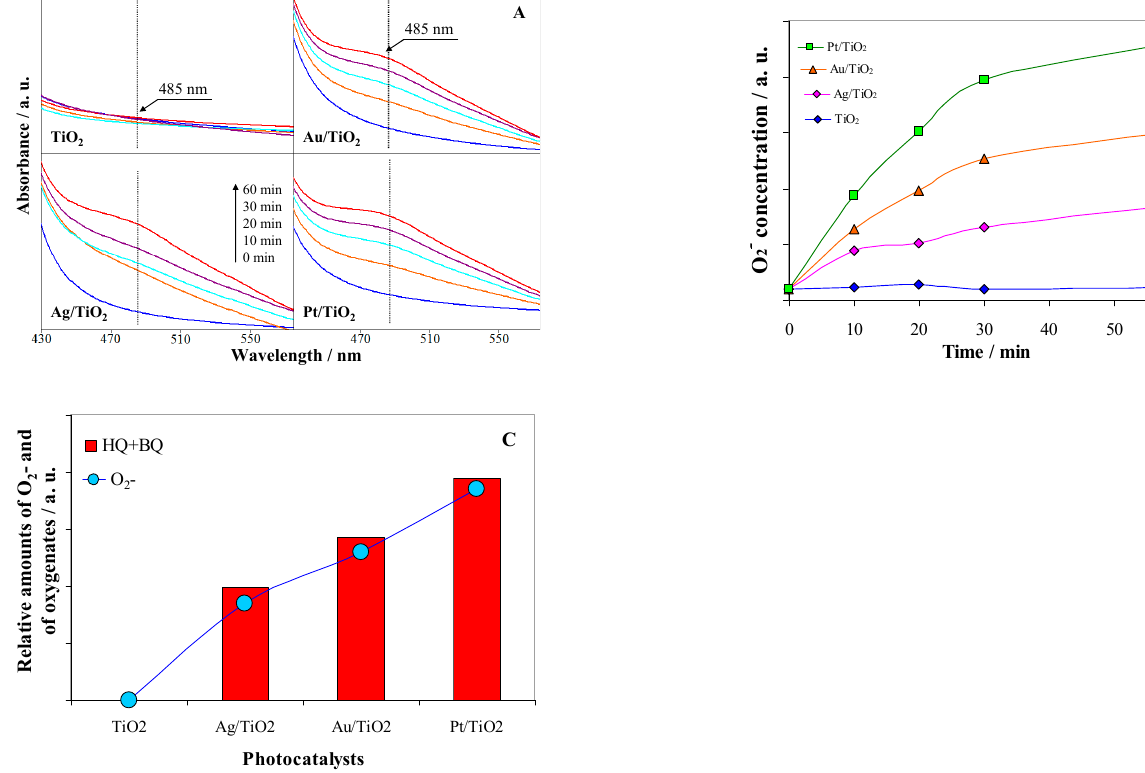
Figure 7. Time course of formazan absorbance ( A ), formed in the reaction between O 2 − and XTT probe molecule, and evolution of O 2 − relative concentration over the catalysts exposed to solar light ( B ). Relative amounts of oxygenates (HQ + BQ) measured at end of reaction in comparison with that of O 2 − ( C ). Experimental conditions: 4 mg of catalysts, dispersed into 3 mL of XTT sodium salt solution, were exposed to simulated solar light to induce the formation formazan, which was put in evidence by the UV-VIS absorption peak at ≈ 470 nm.